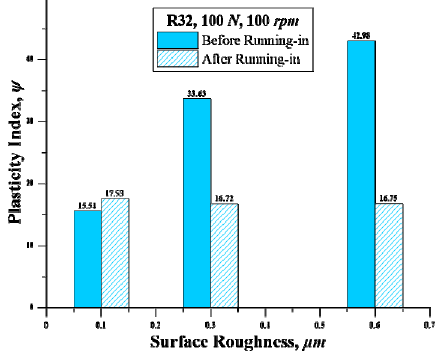
Figure 6. Plasticity index for different surface roughness before and after running-in